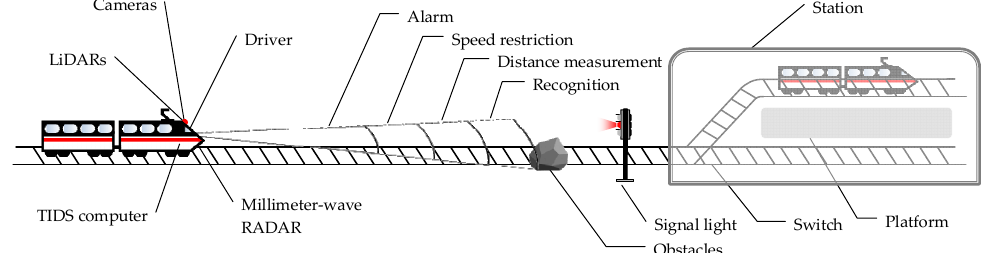
Figure 3. A brief description of the Train Intelligent Detection System.